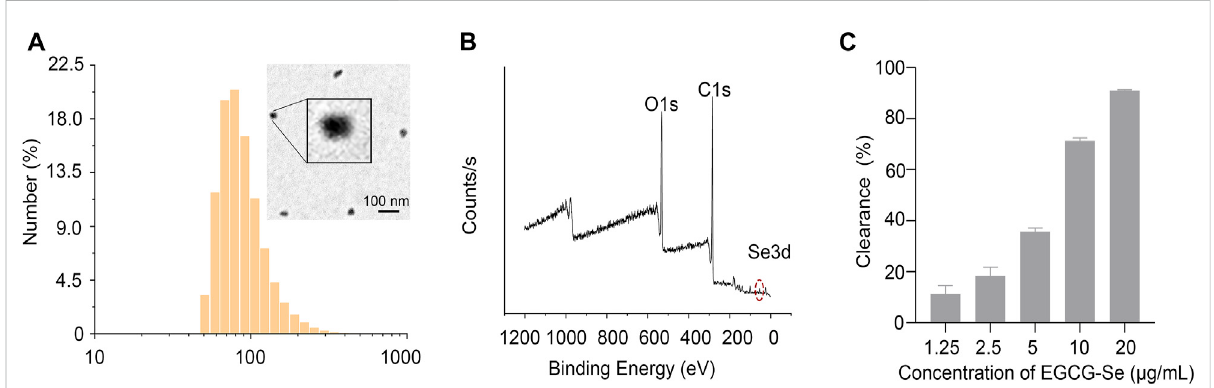
FIGURE 2 Characterization of epigallocatechin-3-gallate selenium nanoparticles (EGCG-Se NP). (A) EGCG-Se NP size distribution was detected by dynamic laser scattering and morphological image of an EGCG-Se NP was obtained via transmission electron microscopy. Scale bar = 100 nm. (B) X-ray photoelectron spectroscopy spectrum of EGCG-Se NP. (C) Clearance of diphenyl picrylhydrazyl by EGCG-Se